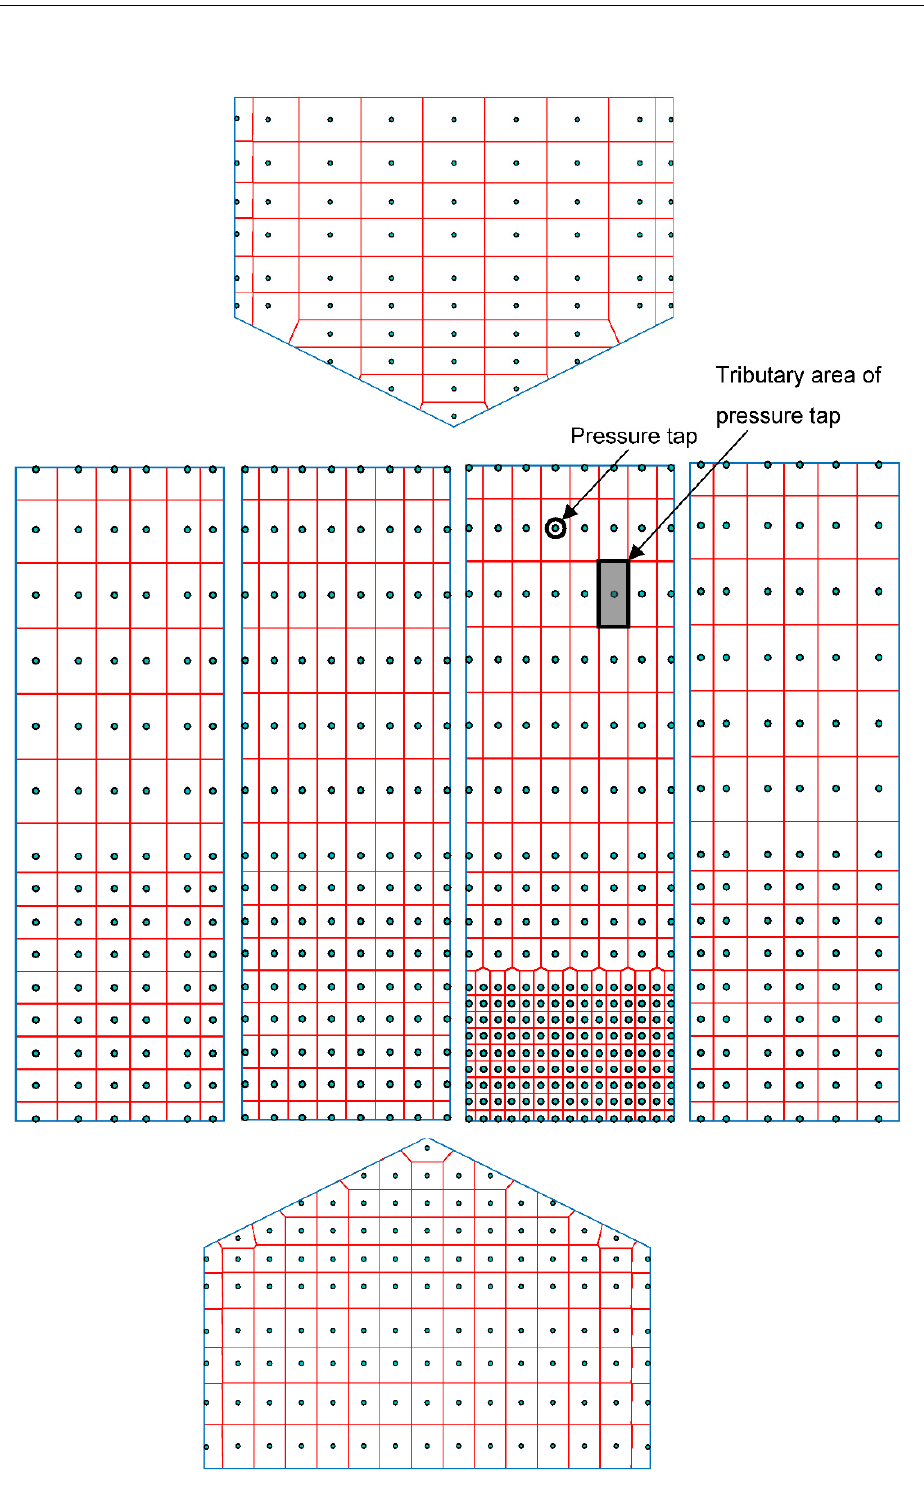
Figure 5. Pressure tap tributary area for 12.2-m eave height building.